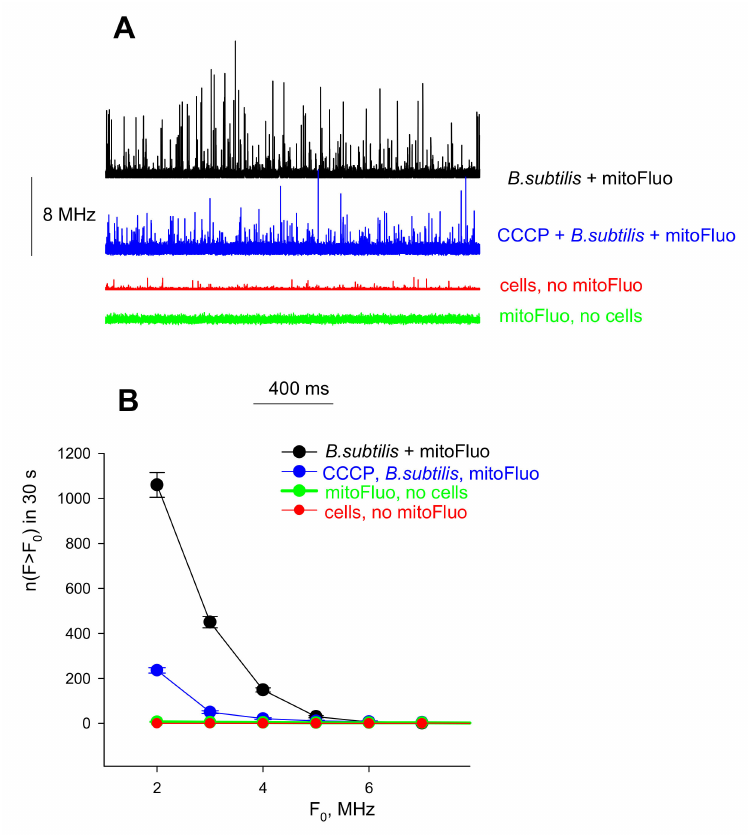
Figure 7. The e ff ect of CCCP (10 µ M) on the accumulation of mitoFluo by B. subtilis cells, monitored by FCS. ( A ) The fluorescence intensity traces of mitoFluo (100 nM) recorded with the FCS set-up in the presence or absence of bacterial cells (10 6 per ml of PBS). ( B ) The corresponding dependences of the number of peaks with the fluorescence intensity F exceeding the threshold F 0 , n (F > F 0 ), on the value of F 0